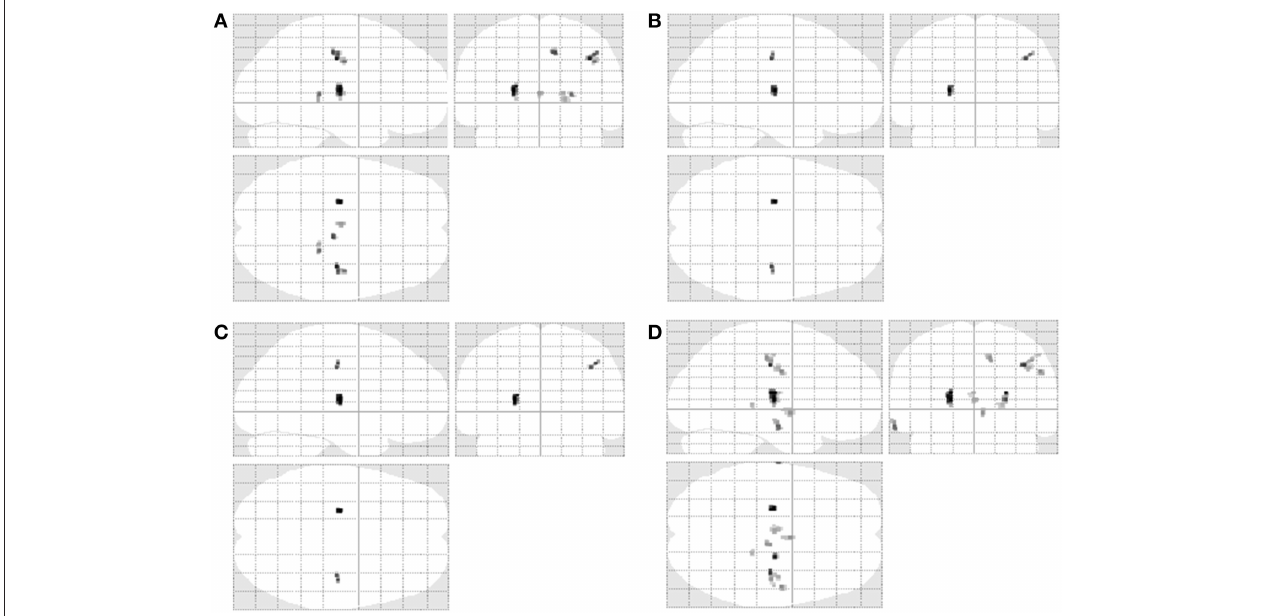
FIGURE 2 | Texture differences in ALS are presented in a glass brain representation: autocorrelation (A, Auto), sum average (B, Savg), sum of squares variance (C, Sosv), and sum variance (D, Svar). Changes are restricted to the right precentral gyrus and corticospinal tract for Savg and Sosv, and additionally include non-motor regions including the thalamus, temporal lobe, and cingulum for Auto and